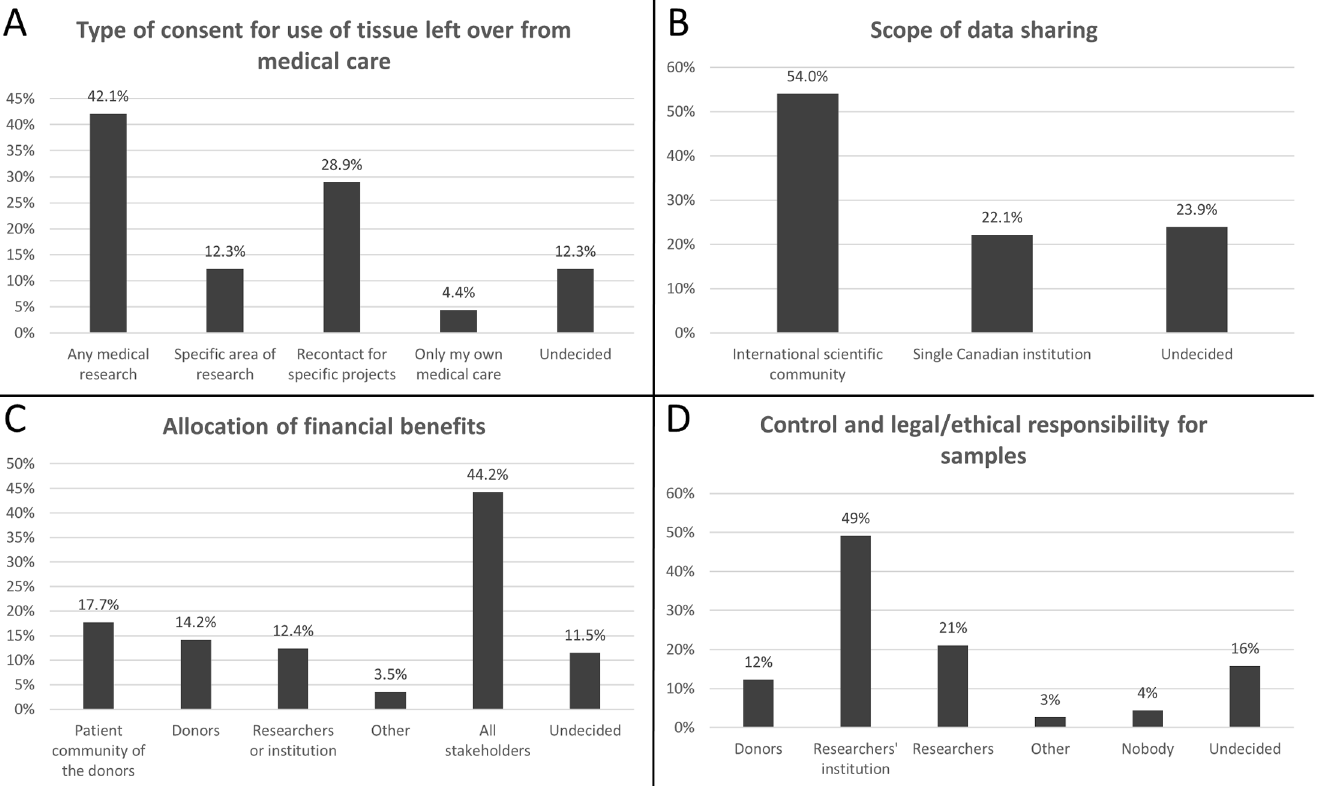
Fig 1. Preferences for consent models, data sharing, allocation of profits and ownership of samples and data. Respondents selected from among the listed options their preferred type of consent (A), scope of data sharing (B), use of any profits from the research (C), control over samples and data (D). All graphics display the percentages of participants opting for provided multiple choices. In order to reflect the fact that some participants used the “ other ” box to select more than one of the listed options, those answers were reassigned to the categories in question, resulting in percentages summing to over 100% in (C) and